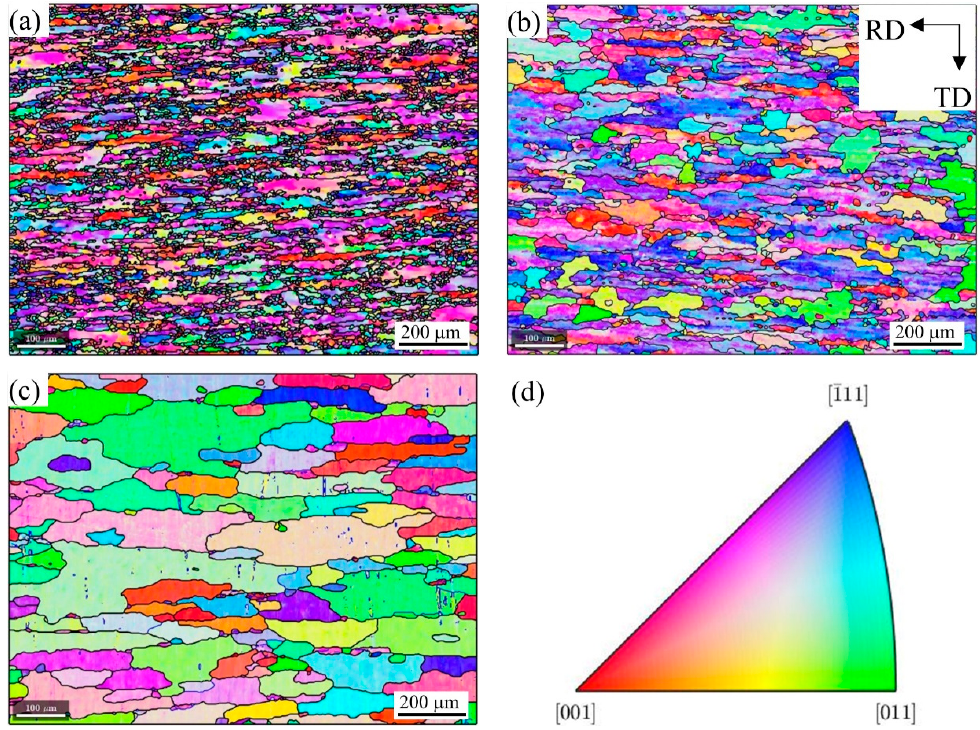
Figure 4. EBSD-IPF images of the 2A14 Al alloy on the RD-TD plane during annealing to ( a ) 505 °C, ( b ) 555 °C, and ( c ) 580 °C; ( d ) IPF grain orientation ruler.